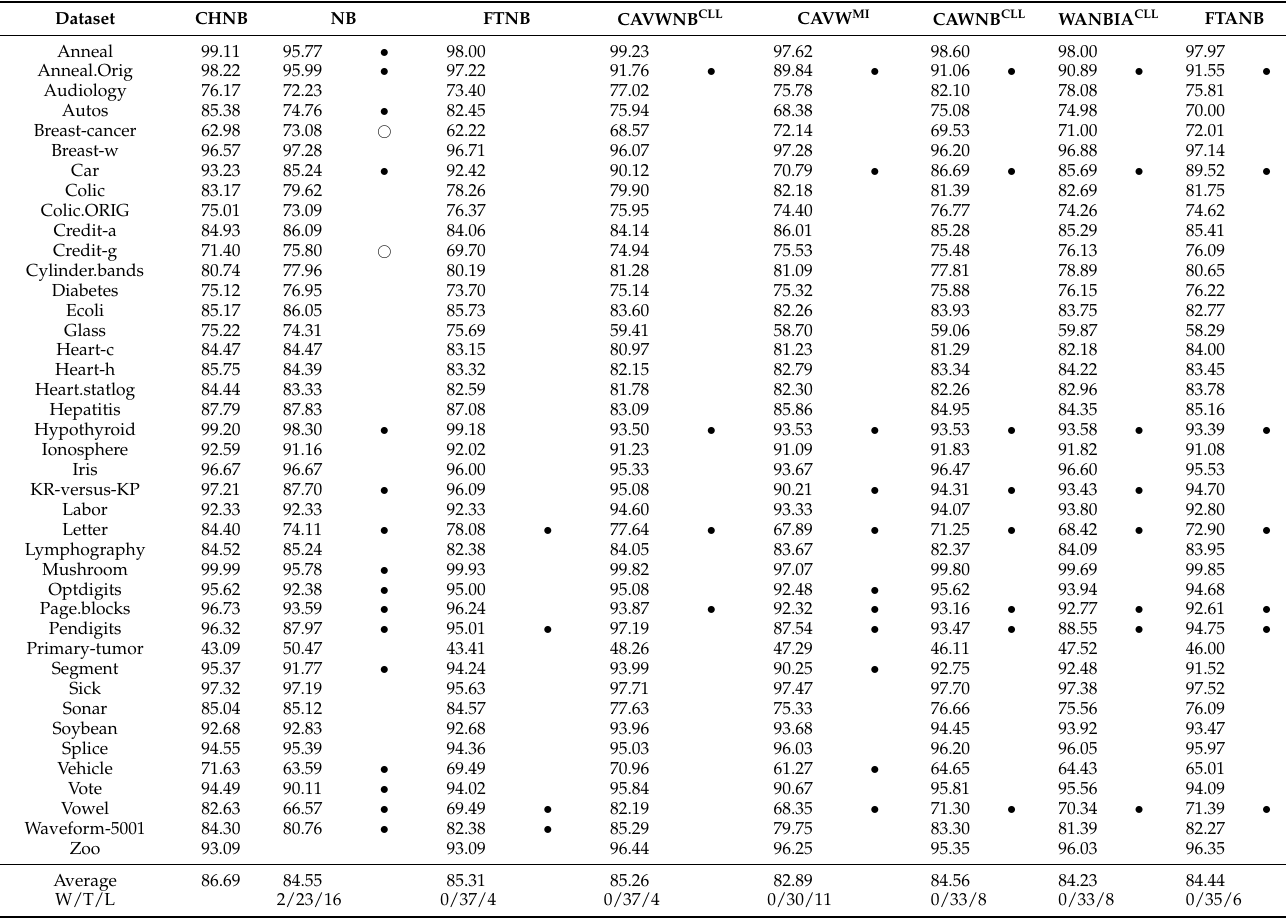
Table 3. Classification performance (Accuracy) comparison results on 41 UCI general datasets.